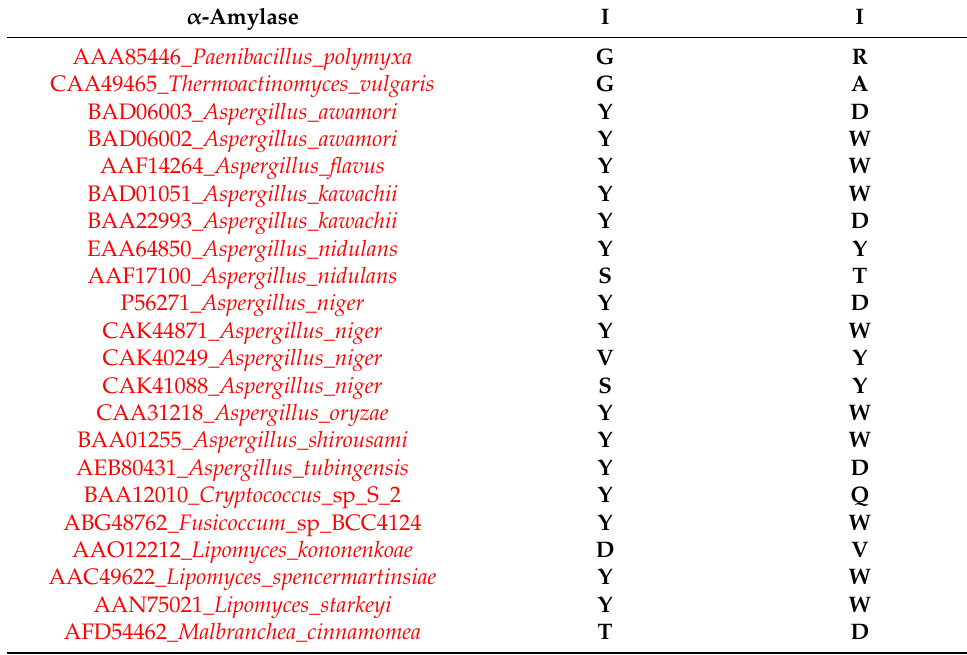
Table 2. Residues corresponding with the SBS from A. niger α -amylase a